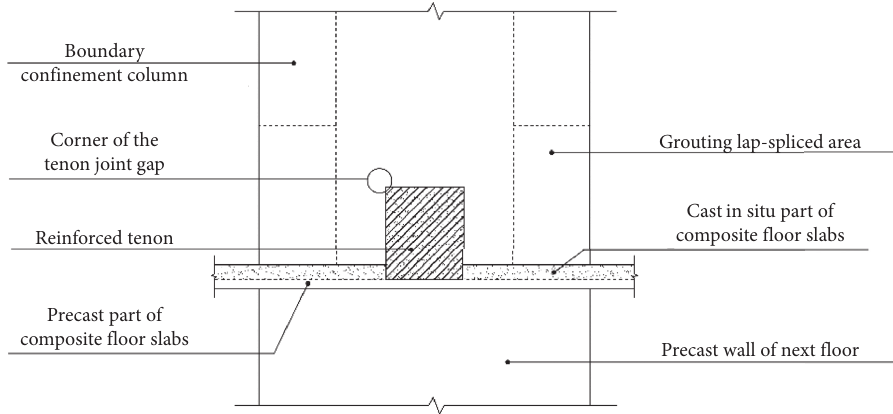
Figure 3: Construction of precast shear wall with the proposed reinforced tenon.